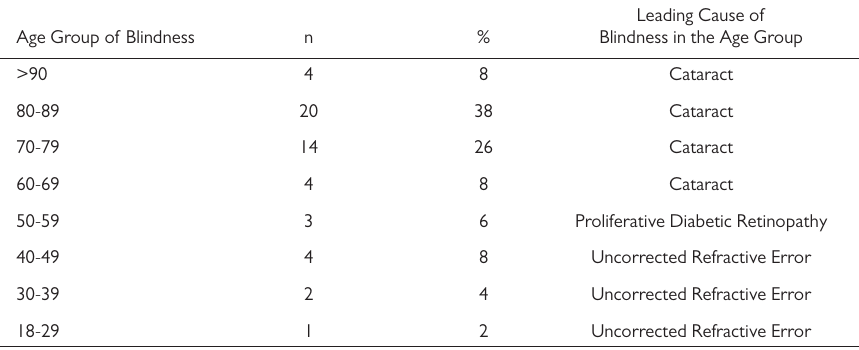
Leading Cause of